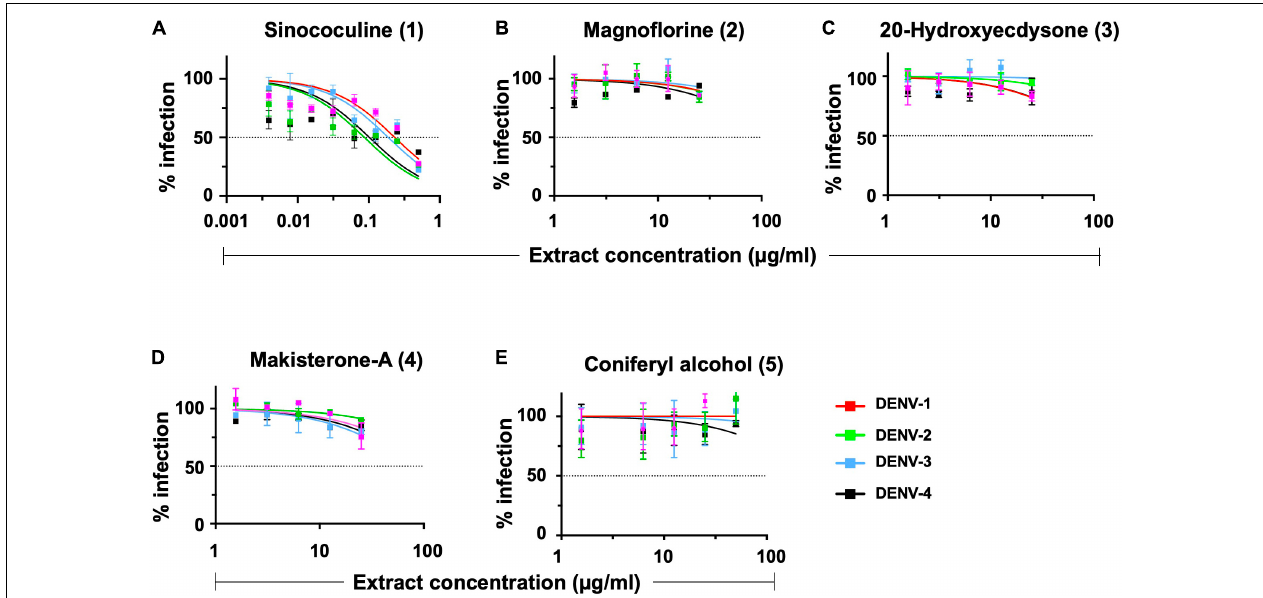
FIGURE 3 | In vitro flow-cytometry-based dengue virus (DENV) inhibition analysis of all AQCH marker compounds. Five makers compounds (A–E) isolated from AQCH were tested for their anti-dengue inhibitory potency against DENV-1 (magenta curve), DENV-2 (green curve), DENV-3 (blue curve), and DENV-4 (black curve) serotypes using in vitro flow-cytometry-based virus inhibition assay. X -axis denotes compound concentrations ( µ g/ml) in each panel, and y -axis represents percent virus inhibition against virus control (no compound was added). Horizontal dotted line of each panels shows 50% inhibition of viral infection as compared with virus control, and IC 50 was calculated for each of compounds using Graphpad